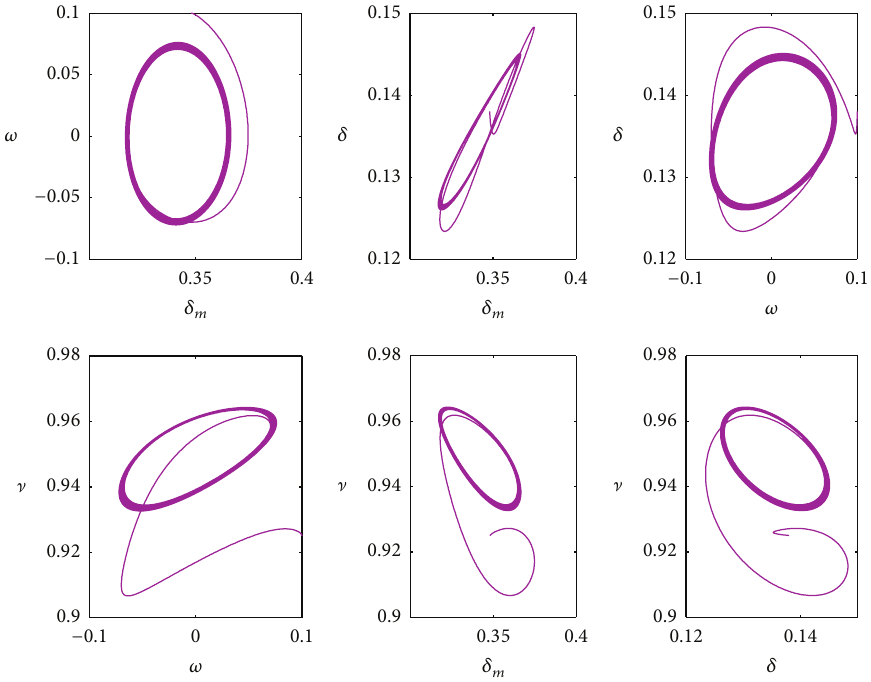
Figure 3: The 2D trajectory in the fractional-order power system with 𝑞 𝑖 = 0.99 , 𝑖 = 1,2, 3, 4 .